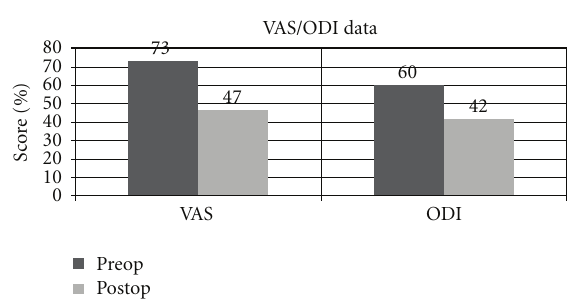
Figure 5: Graph demonstrating pre- and postoperative values for visual analogue scale (VAS) and Oswestry Disability Index